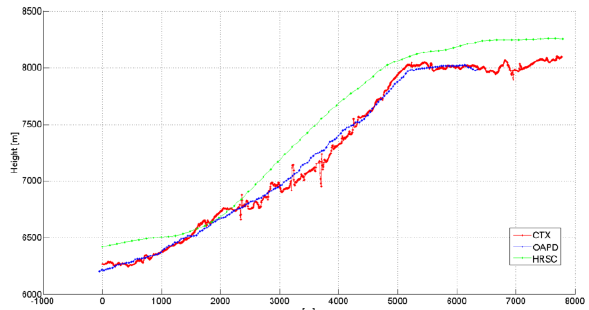
Figure 10 A vertical profile line was used as slice definer of the